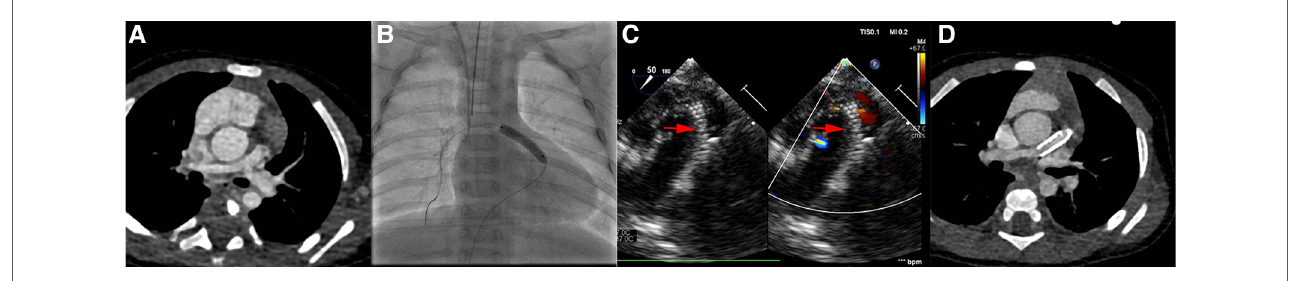
FIGURE 2 Images in ROVT stenting group. ( A ), patients ’ pulmonary artery CTA image before procedure. ( B and C ), the pulmonary artery and ROVT stent image during procedure under Digital subtraction angiography or Ultrasound. ( D ), CTA image before fi nal surgical repair. The red arrow indicates the stent